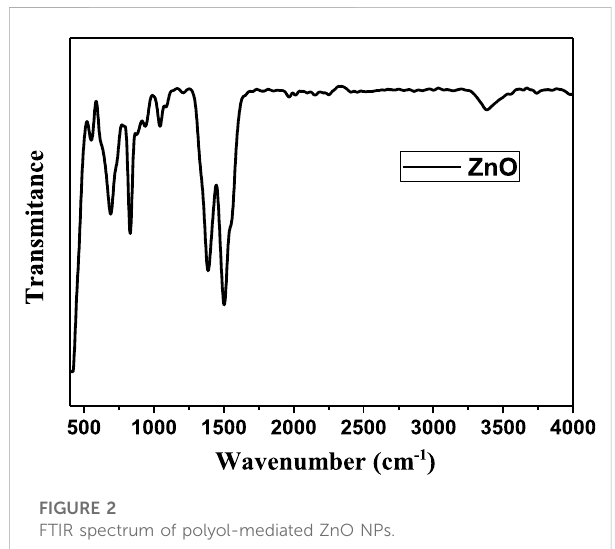
FIGURE 2 FTIR spectrum of polyol-mediated ZnO